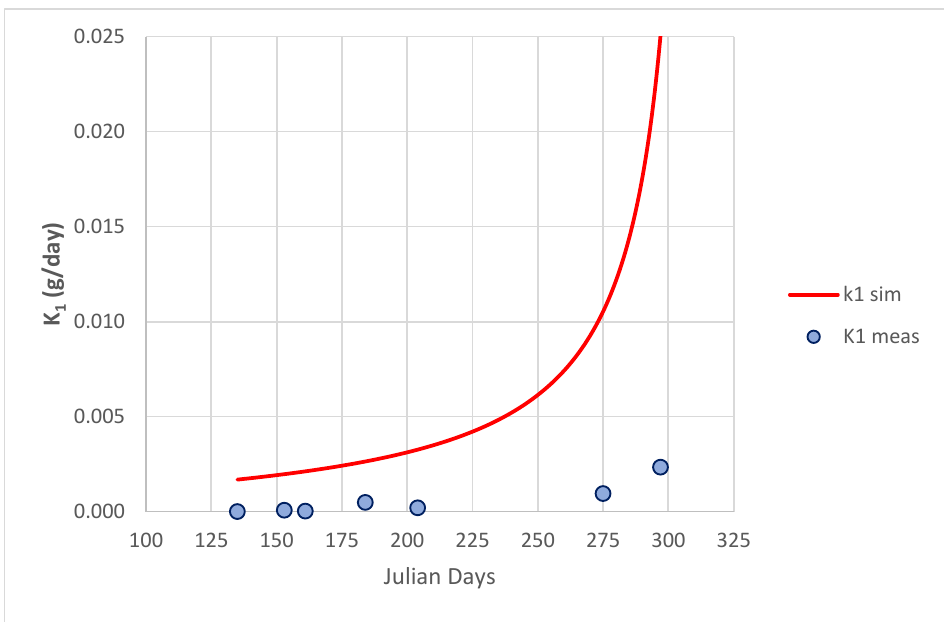
Figure 4. Simulated k 1 values (g/day) obtained by Equation 9 (continuous line in red) and the observed ones obtained by Equation 8 (points in blue).